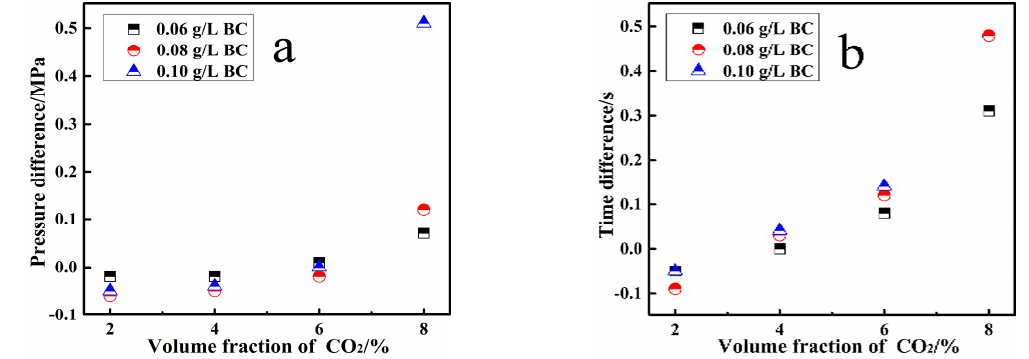
Figure 6. The difference between the actual effect and the theoretical addition effect of BC/CO 2 : ( a ) the difference of the max-pressure; ( b ) the difference of the time to max-pressure.